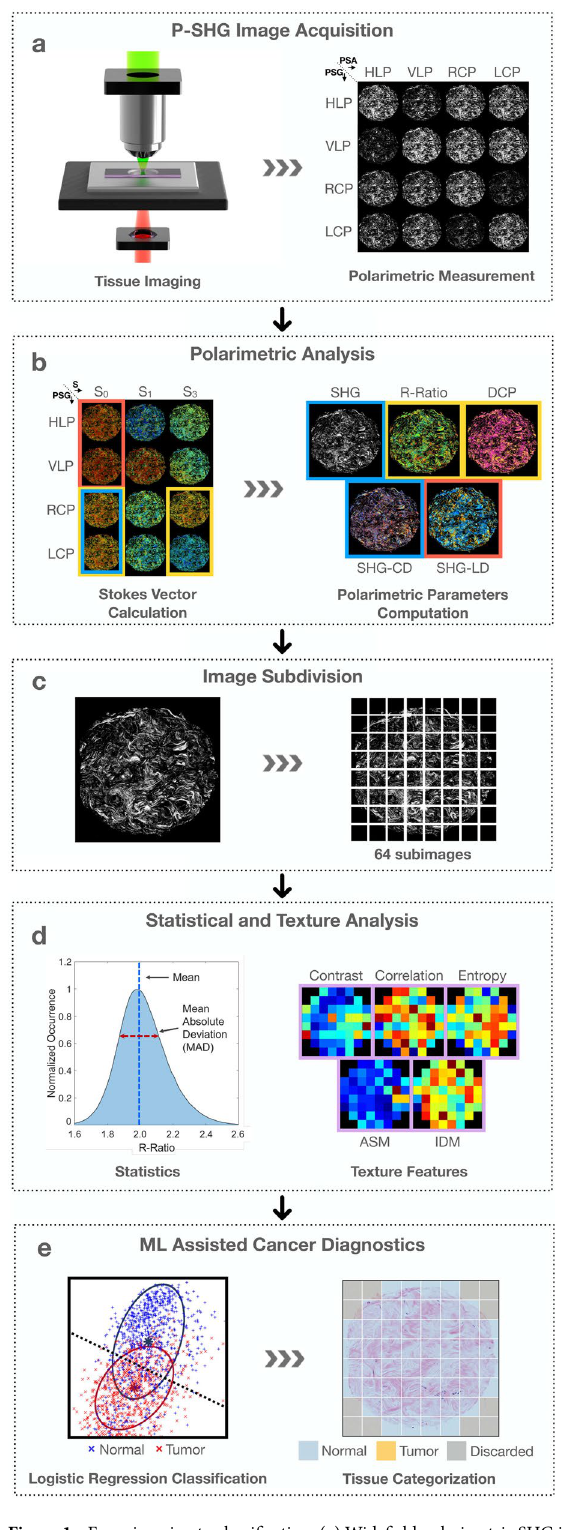
Figure 1. From imaging to classification. ( a ) Widefield polarimetric SHG imaging of the sample at 16 unique polarization state combinations, prepared by the polarization state generator (PSG) and the polarization state analyzer (PSA), which correspond to horizontal linearly polarized (HLP), vertically linearly polarized (VLP), right and left circularly polarized states (RCP and LCP), respectively. ( b ) Calculation of SHG Stokes vector elements to compute polarimetric parameter images. On the left, image shows breast tissue core pseudo-color images of s 0 , s 1 and s 3 component at PSG states of HLP, VLP, RCP and LCP respectively. The right image shows polarimetric parameter maps of the core for SHG intensity, R-Ratio, DCP, SHG-CD and SHG-LD. ( c ) Subdivision of polarimetric images into 64 sub-images, to allow high-resolution texture analysis and statistical significance testing. ( d ) Calculation of mean and mean absolute deviation of polarimetric parameter, as well as contrast, correlation, entropy, angular second moment (ASM), and inverse difference moment (IDM) texture parameters of each sub-image. ( e ) Training of a logistic regression classifier using the polarimetric and texture parameters, and the subsequent prediction to differentiate normal and tumor